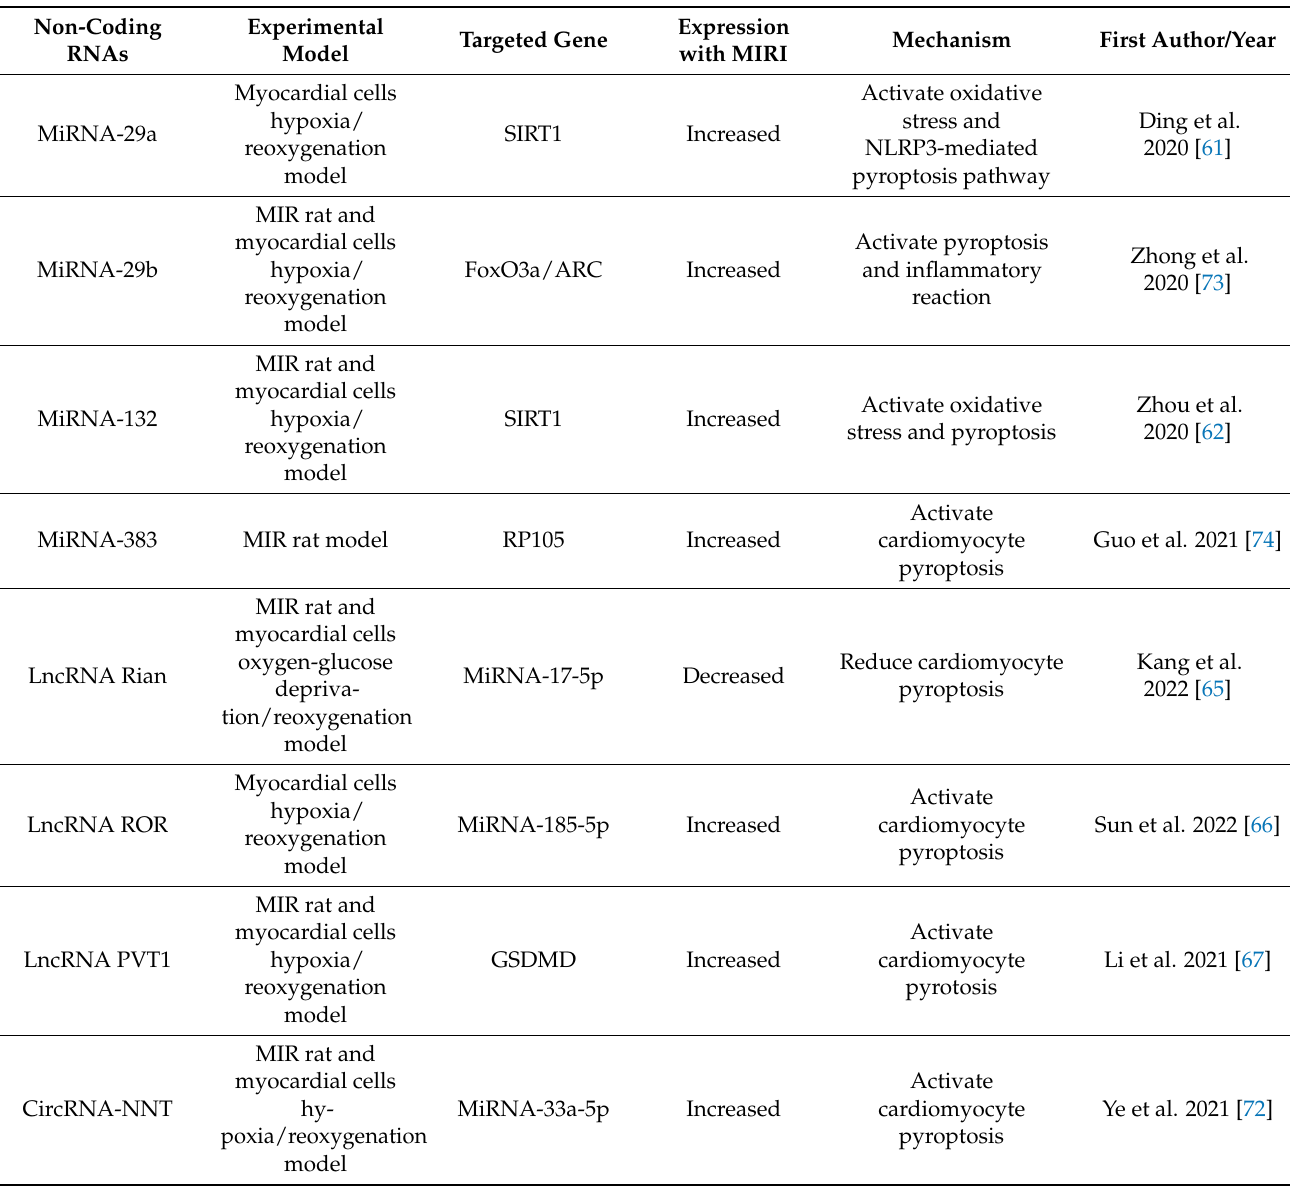
Table 1. Non-coding RNAs affect myocardial ischemia-reperfusion injury by regulating pyroptosis. Non-Coding